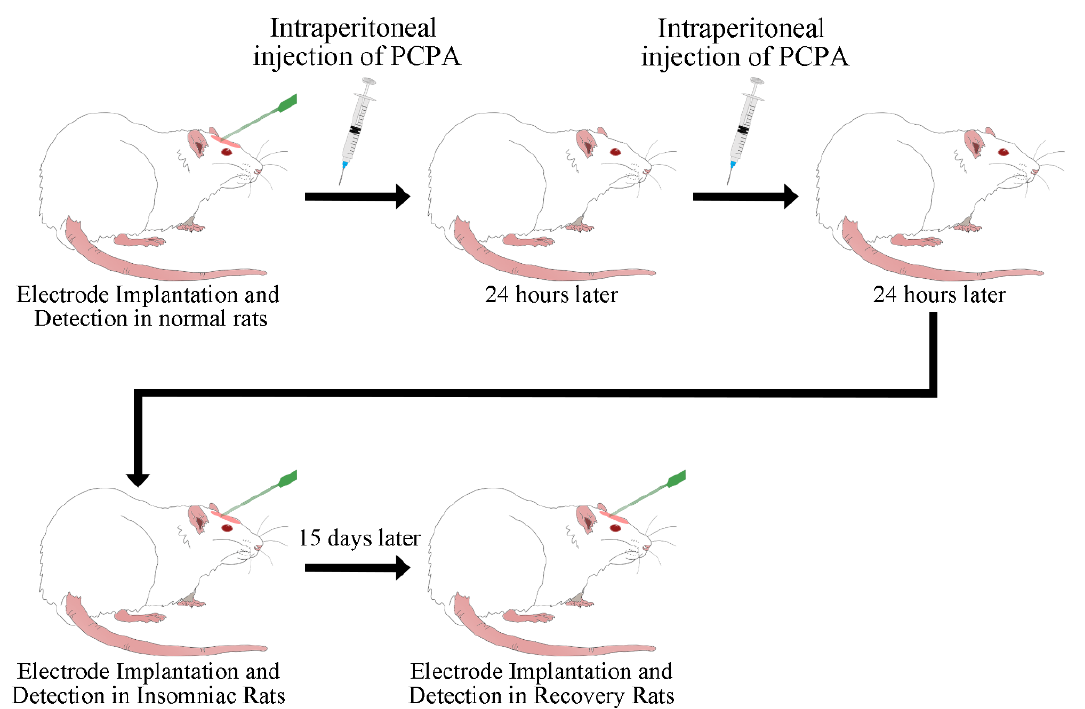
Figure 1. Schematic diagram of the experimental arrangement.